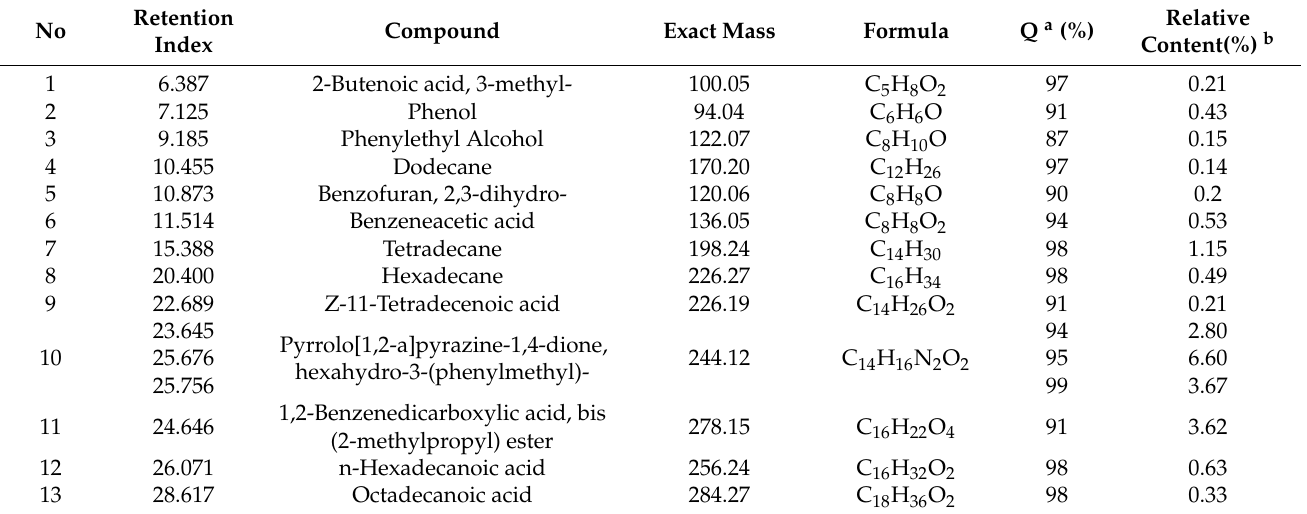
Figure 5. Chemical structures of the identified compounds from ethyl acetate extracts of Bacillus subtilis L1-21 using GC–MS. Table 1. Components of ethyl acetate extract from Bacillus subtilis L1-21 by using GC-MS